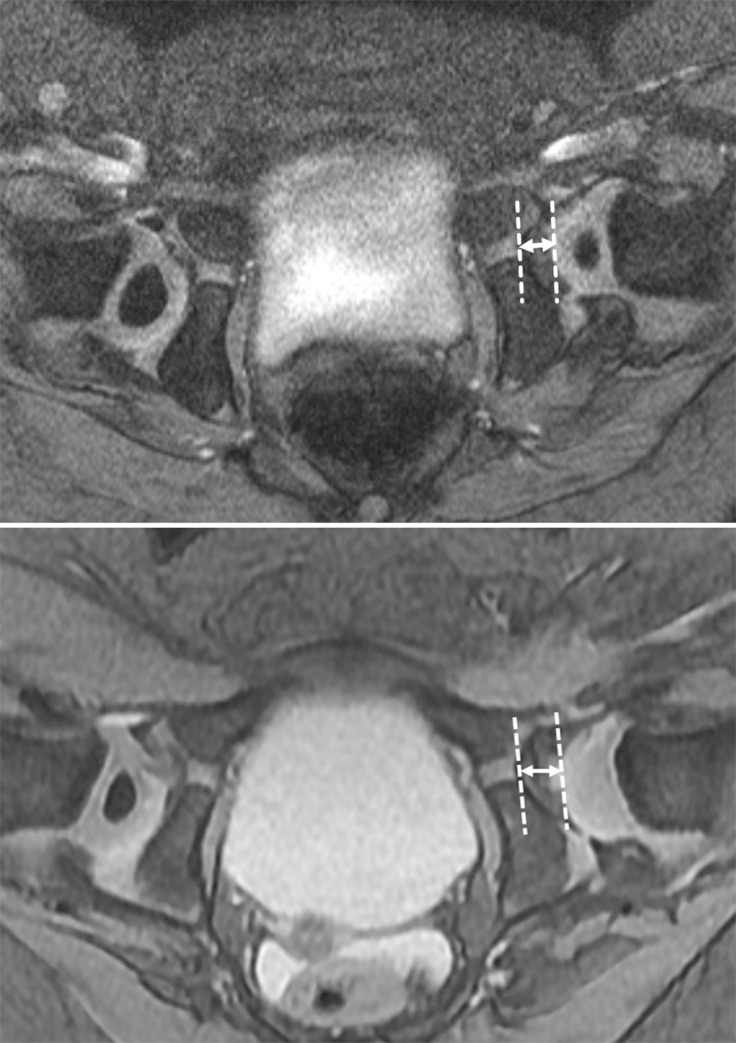
Femoral head position: Concentric reduction vs. eccentric reduction.A. Medial joint space distance is defined as the distance between the triradiate cartilage and femoral capital epiphysis. If the medial joint space width is 3 mm or less, it is defined as a concentric reduction. B. Eccentric reduction of the left DDH in a 17-month-old girl. Medial joint space distance is 6 mm. Note the dysplastic left acetabulum and no visible ossification center of the left proximal femoral epiphysis.